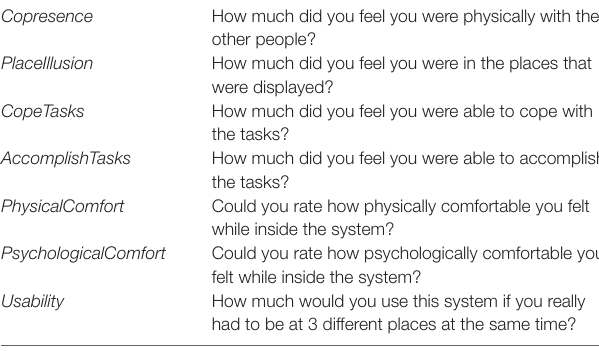
TaBle 1 | Questions related to Pi, copresence, task performance, comfort, and system usability. Copresence